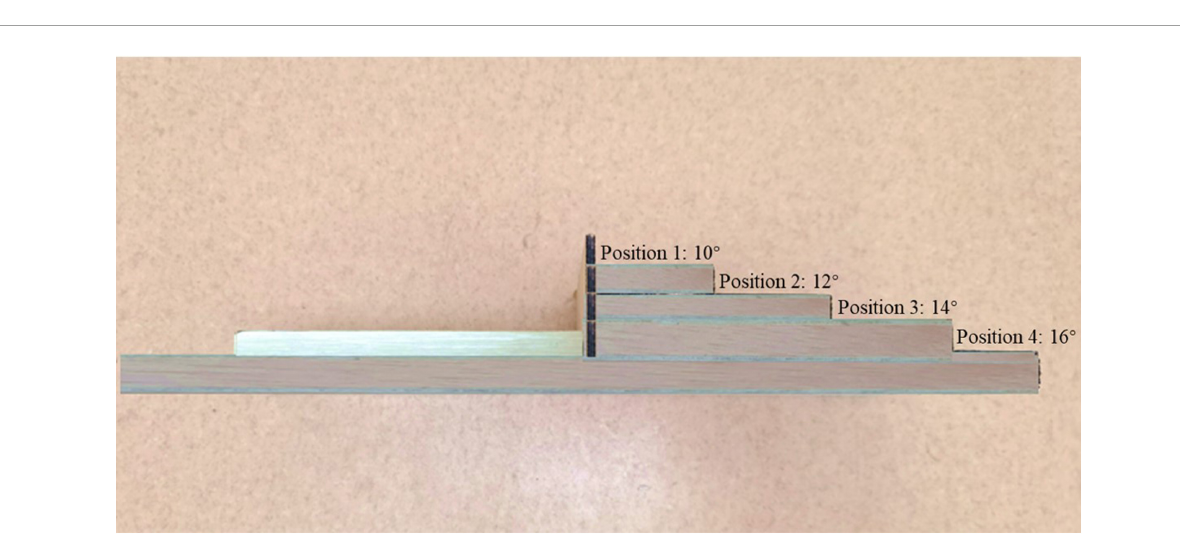
FIGURE2 The lateral view of the physical stops generates ankle inversion angles of 10, 12, 14, and 16